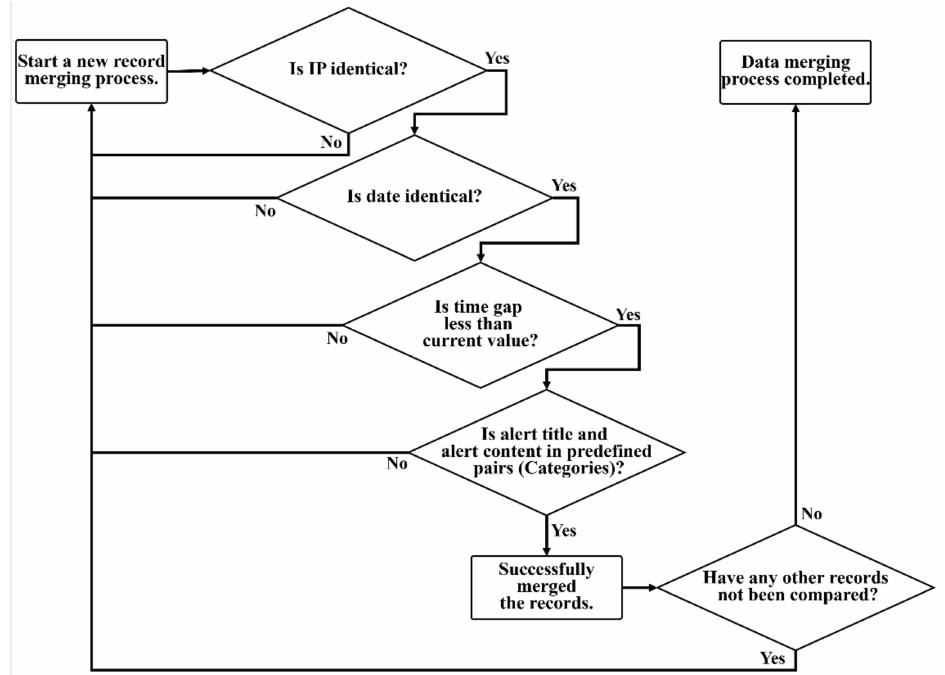
Figure 2. The flowchart of the data merging process. The process of calculating the time gaps between the respective ALC (Alert Log Collector) and DWD (Dominant Window Detector) records is shown in Figure 3. The smallest time gaps between the dominant window records and the alert log records were interpreted to indicate that these records had been derived from the same alert window (thicker